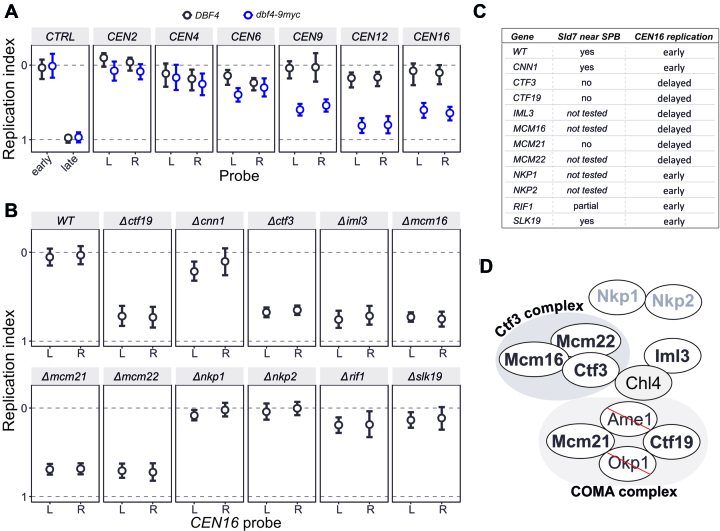
Identification of trans-acting factors regulating centromere replication timing. (A) Replication of DNA at centromeres is delayed in a dbf4-9myc mutant, as previously reported (42). Replication timing of 6 centromeres was analysed by calculating replication indices (where zero and one are defined as the S phase DNA copy number of ARS607.L2 and chrXIV:222kb, respectively). Additionally, control early (ARS428) and late (chrIV:966kb) probes are shown. (B) Application of ddPCR to rapidly screen for trans-acting factors that affect DNA replication timing. Replication timing of two CEN16 proximal probes (left and right) was analysed in wild type cells or cells with the indicated gene deletions. (C) Table summarizing results in B and comparing them to a previously reported screen (42) for Sld7 co-localization with the spindle pole body (SPB). (D) Schematic representation of the Ctf19 kinetochore sub-complex (modified from (51)) indicating components that affect centromere replication timing. In bold black text—tested components; in grey text—components whose deletion affected replication timing, in light grey—components that did not affect replication timing; crossed—essential components that were not tested.